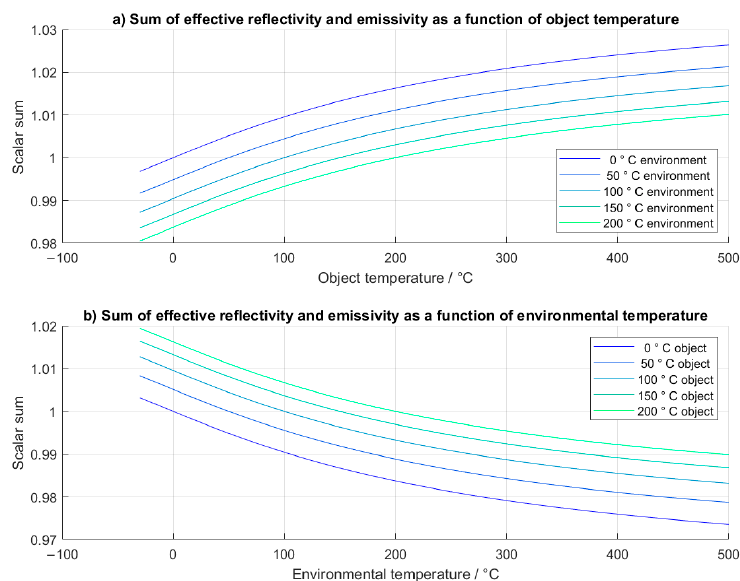
Figure 16. Sum of effective scalar emissivity and reflectivity with ( a ) object and ( b ) environmental temperature. Multiple plots show variation of ( a ) environmental and ( b ) object temperature.